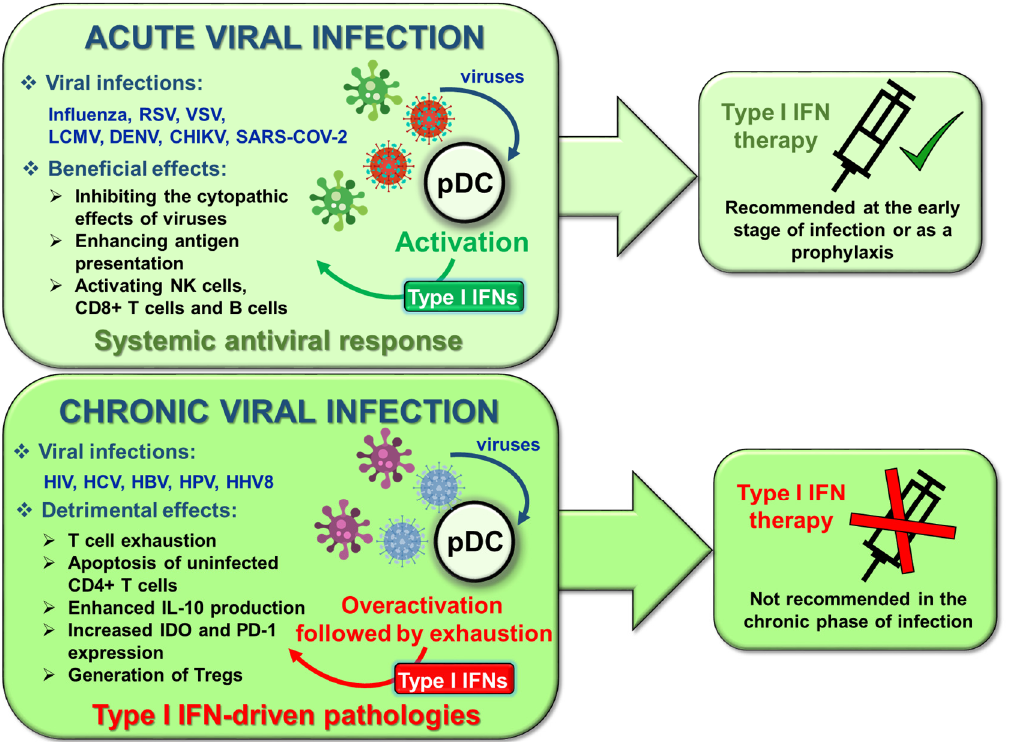
Figure 2. The Janus-faced role of pDCs in viral infections. Via producing large amounts of type I IFNs, pDCs are essential to initiate an effective antiviral response. Recombinant type I IFN therapy is suggested for the treatment of acute viral respiratory tract infections or as a prophylaxis ( upper panel ). On the contrary, persistent and uncontrolled activation of pDCs leads to type I IFN-driven pathologies upon chronic viral infections. Therefore, the use of type I IFNs is not recommended for the treatment of chronic viral infections as it may exacerbate pre-existing inflammation ( lower panel ). CHIKV: chikungunya virus; DENV: dengue virus; HBV: hepatitis B virus; HCV: hepatitis C virus; HHV8: human herpesvirus 8; HIV: human immunodeficiency virus; HPV: human papillomavirus; IDO: indoleamine-2,3-dioxygenase; IFN: interferon; IL: interleukin; LCMV: lymphocytic choriomeningitis virus; NK: natural killer; PD-1: programmed cell death protein 1; pDC: plasmacytoid dendritic cell; RSV: respiratory syncytial virus; SARS-COV-2: severe acute respiratory syndrome coronavirus 2; VSV: vesicular stomatitis virus.